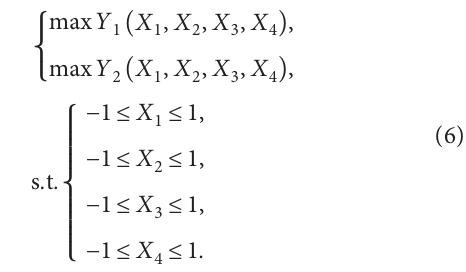
Figure 12: Response surface of optimization